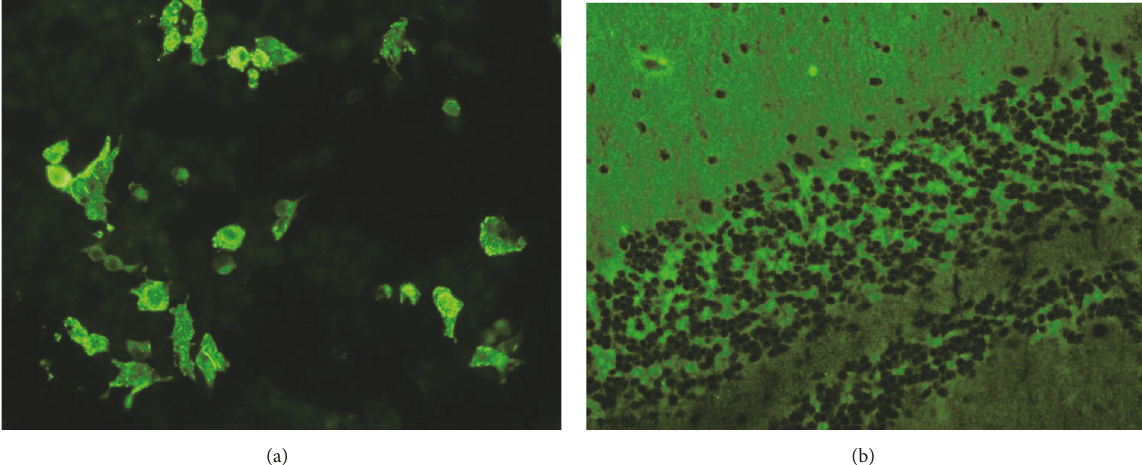
Figure 2: Anti-NMDAR antibodies detected by indirect immunofluorescence . (a) Hek293 transfected cells; (b) granular layer of cerebellum in tissue of rat.